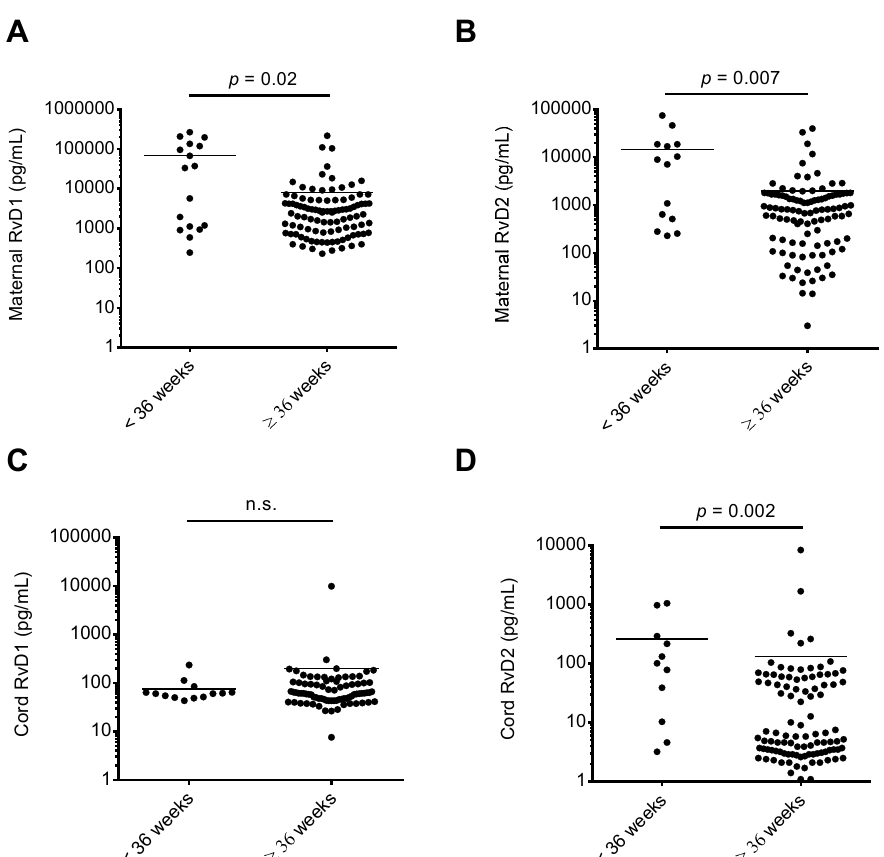
Figure 3. Comparison of maternal and cord blood plasma RvD1 and RvD2 levels and gestational age at delivery. Maternal and cord blood RvD1 and RvD2 levels were separated into infants delivering at less than 36 weeks estimated gestational age versus infants delivered at greater than or equal to 36 weeks estimated gestational age and compared. ( A ) Maternal RvD1 levels; ( B ) maternal RvD2 levels; ( C ) cord RvD1 levels; ( D ) cord RvD2 levels. n.s.: no significant difference.